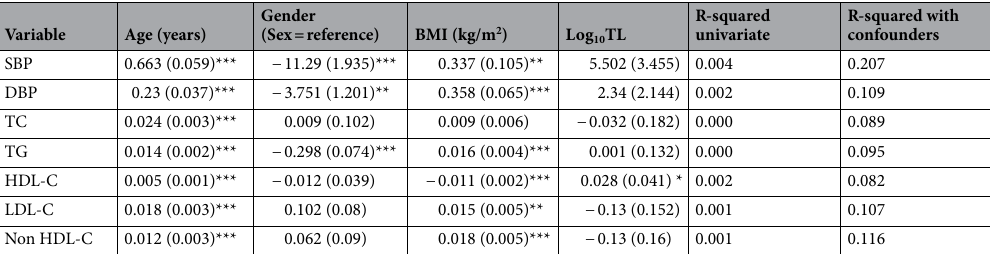
Table 4. Linear regression models (coefficients and standard errors) for the associations of Log 10 telomere length with cardio-metabolic variables. Legend: SBP systolic blood pressure, DBP diastolic blood pressure, TC total cholesterol, TG triglyceride, HDL-C high density lipoprotein cholesterol, LDL-C low density lipoprotein cholesterol, BMI body mass index, TL telomere length, *** = p < 0.001, * = p < 0.05.